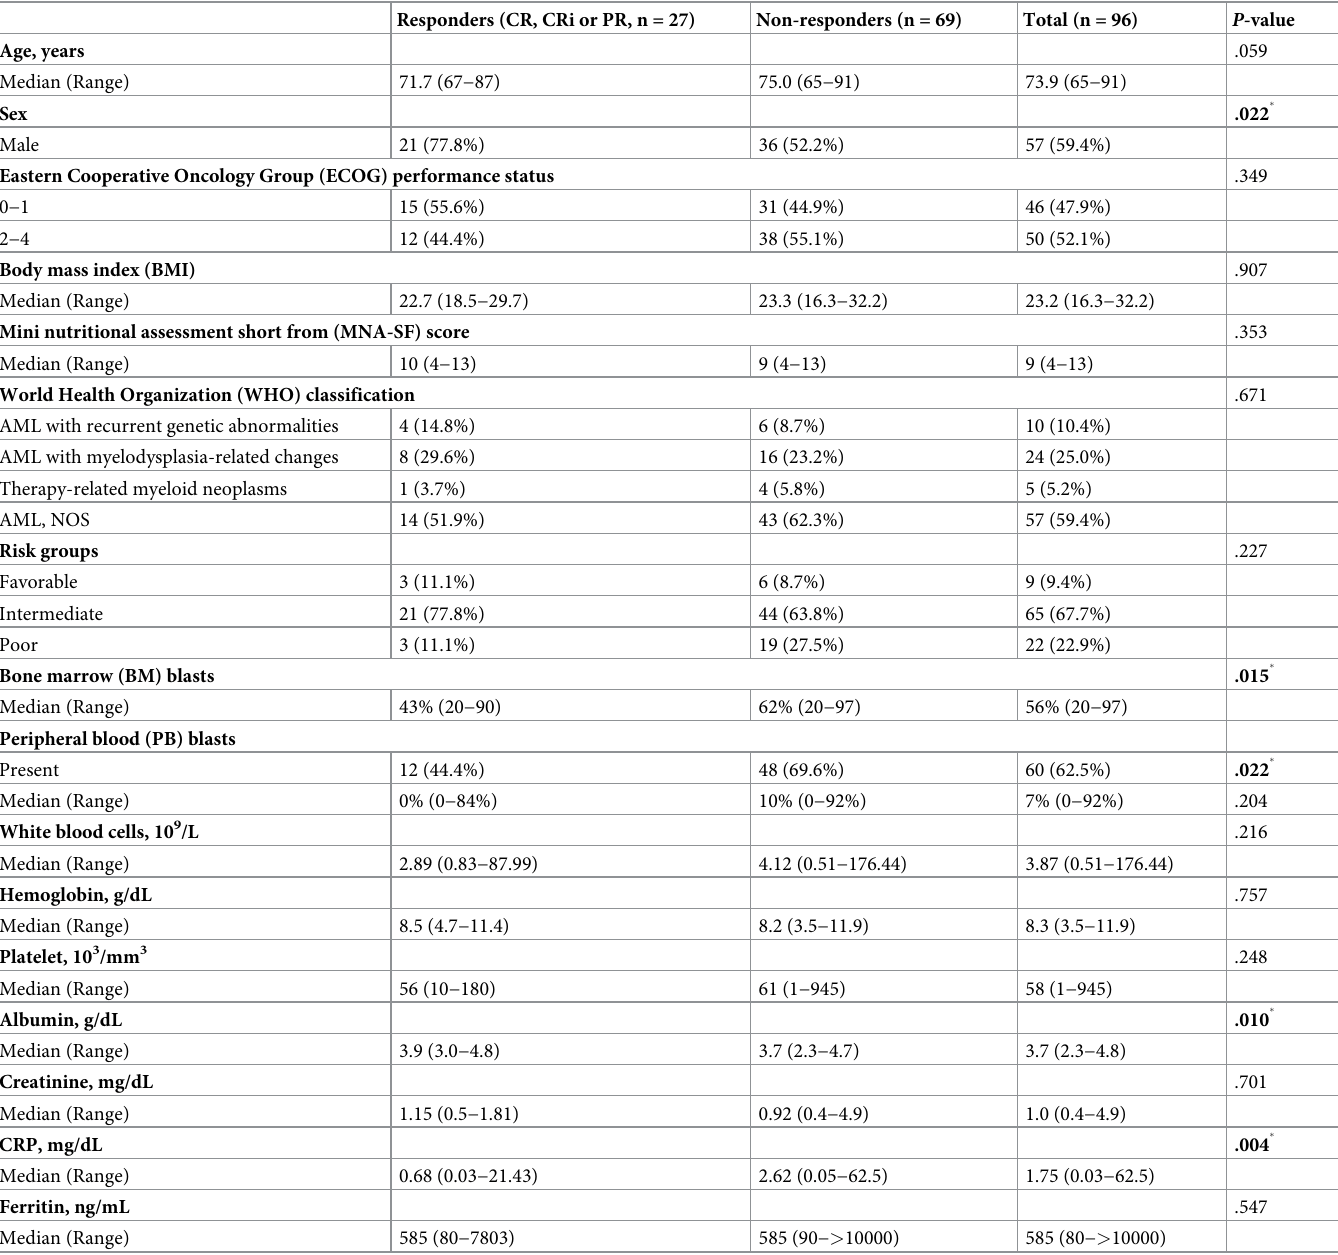
Table 3. Comparison of responders and non-responders to